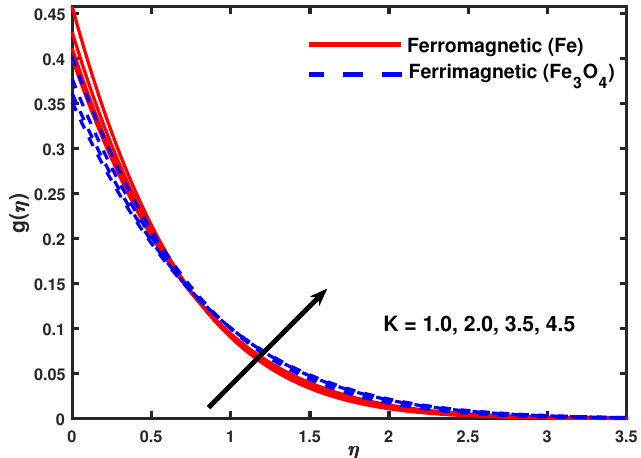
Figure 9. Impact of magnetic nano-particles and micro-rotation parameter ( K ) on the micro-rotaion velocity g ( η )